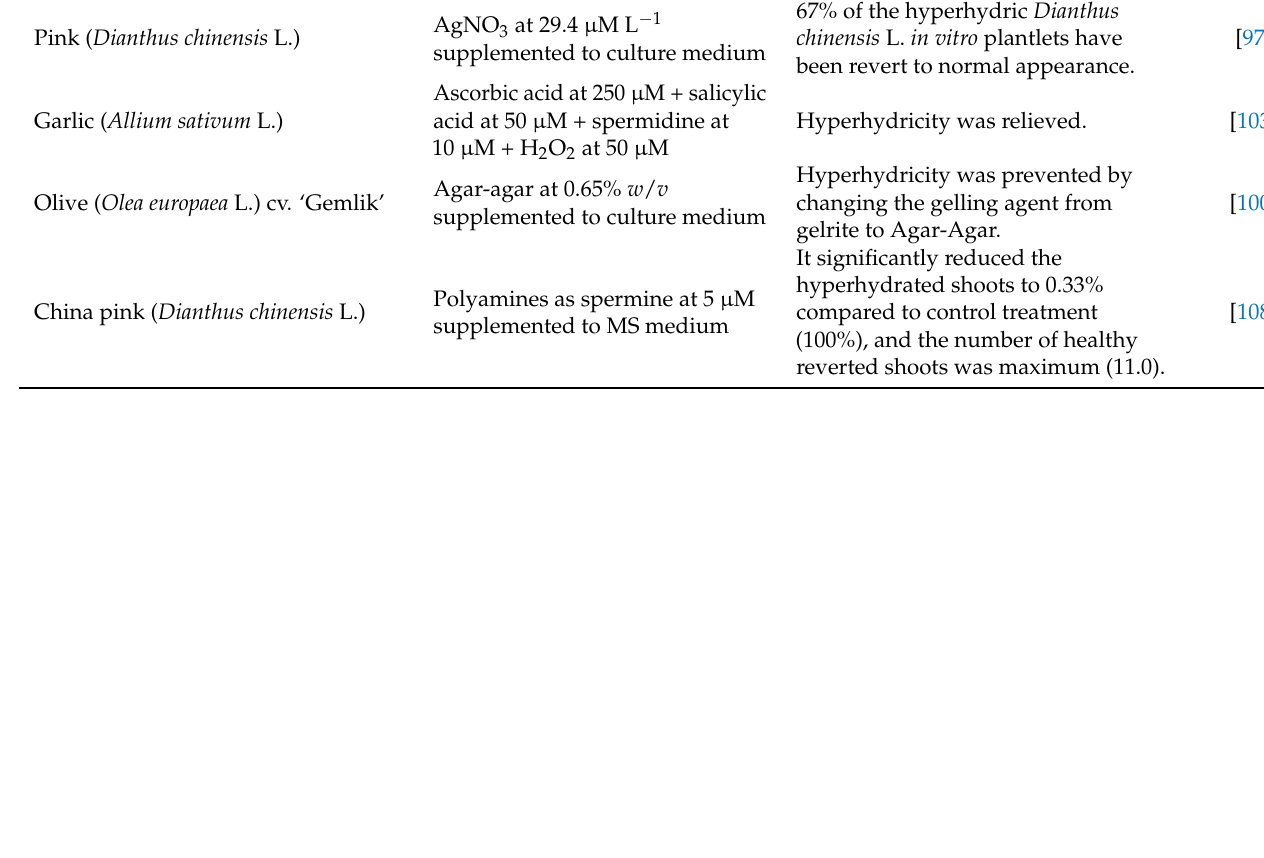
Table 3. Some substances used to control hyperhydricity in plant-tissue cultures. Applied Substance (Name Plant Species/Cultivar